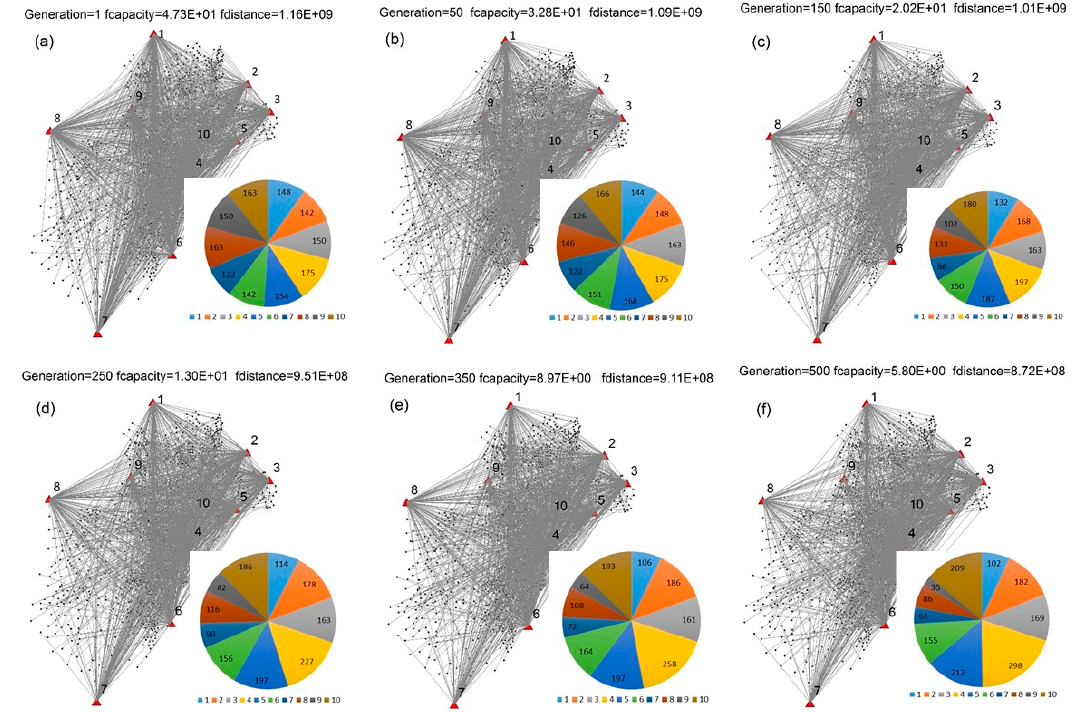
Figure 12. Improvement of optimum solutions through generations. The gray lines on the left side of each graph represent the allocation of shelters. The numbers of building blocks assigned to shelters are presented on the right side of each graph (pie chart). ( a ) Optimal allocation and minimum fitness value obtained from one generation; ( b ) optimal allocation and minimum fitness values of the 50th generation; ( c ) optimal allocation and minimum fitness values of the 150th generation; ( d ) optimal allocation and minimum fitness values of the 250th generation; ( e ) optimal allocation and minimum fitness values of the 350th generation, and ( f ) optimal allocation and minimum fitness values of the 500th generation.